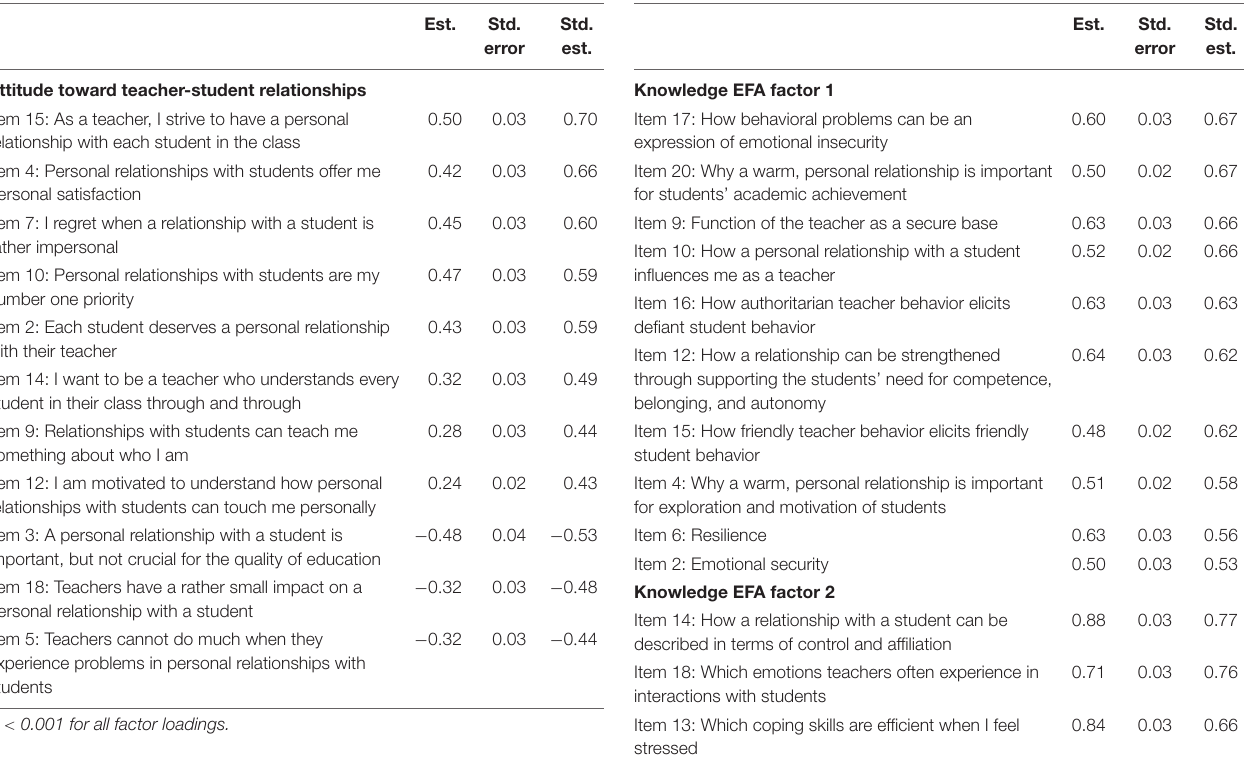
TABLE 5 | Results of confirmatory factor analysis for affect-motivation.